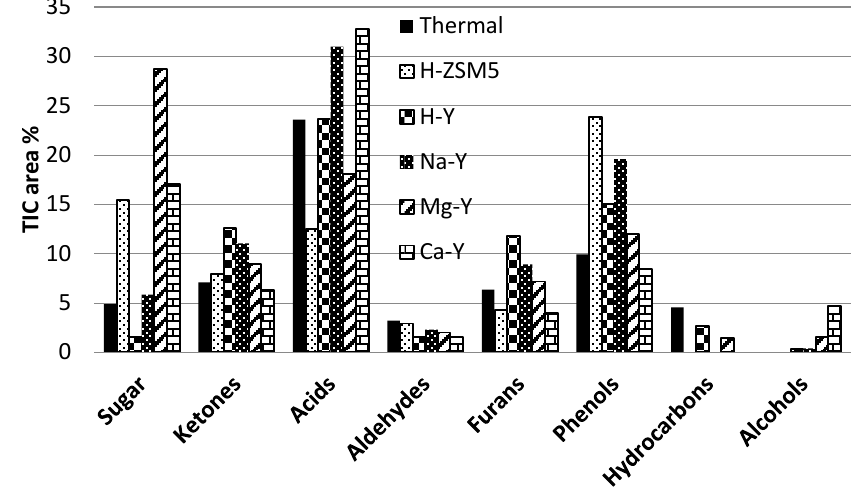
Figure 7. Chemical composition of the bio-oil obtained by non-catalytic and catalytic pyrolysis of biomass.